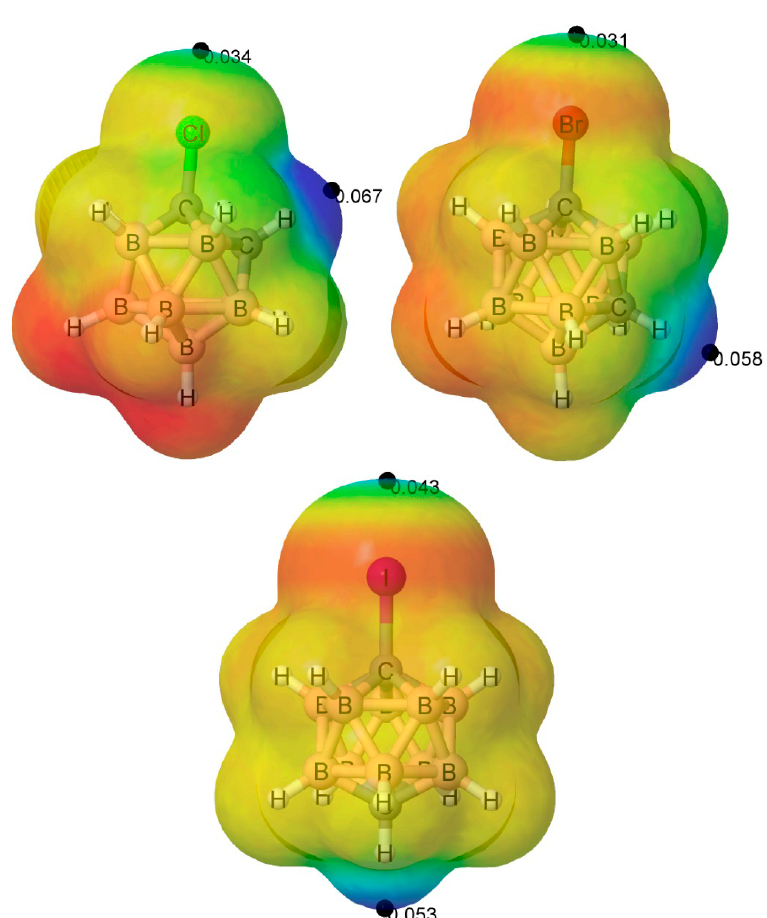
Figure 1. The molecular electrostatic potential (MESP) of three of the systems studied. The MESP energy values range between − 0.015 (red) and 0.05 au (blue). The location of the V s,max is indicated with black circles, and its value is indicated in au.